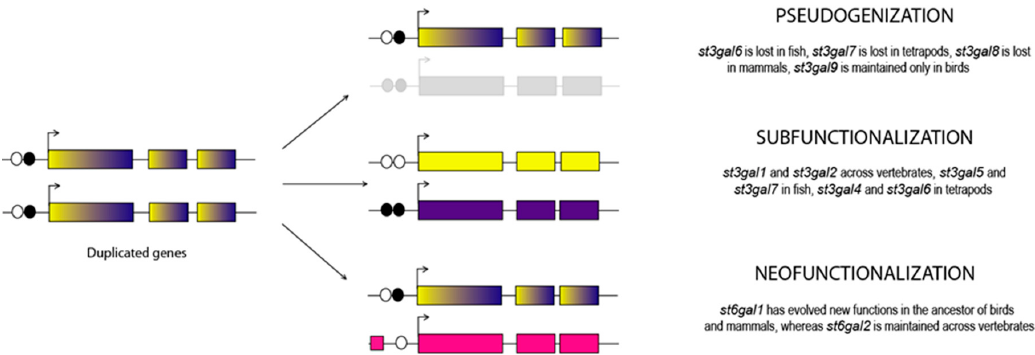
Figure 7. Evolutionary fate of ST gene duplicates after WGD events. On the left side, schematic representation of ancestral polyexonic ST genes duplicates (exons are represented by colored boxes and genomic regulatory elements are represented by black and white circles). On the right side, the three major evolutionary fates of the various newly created ST gene subfamilies are indicated (1) pseudogenization: gene loss; (2) subfunctionalization: coding sequences and regulatory elements evolve and are partitioned according to specific molecular functions; (3) neofunctionalization: one of the newly duplicated gene accumulates mutations in its coding region and/or in its regulatory genomic elements giving rise to new molecular function.